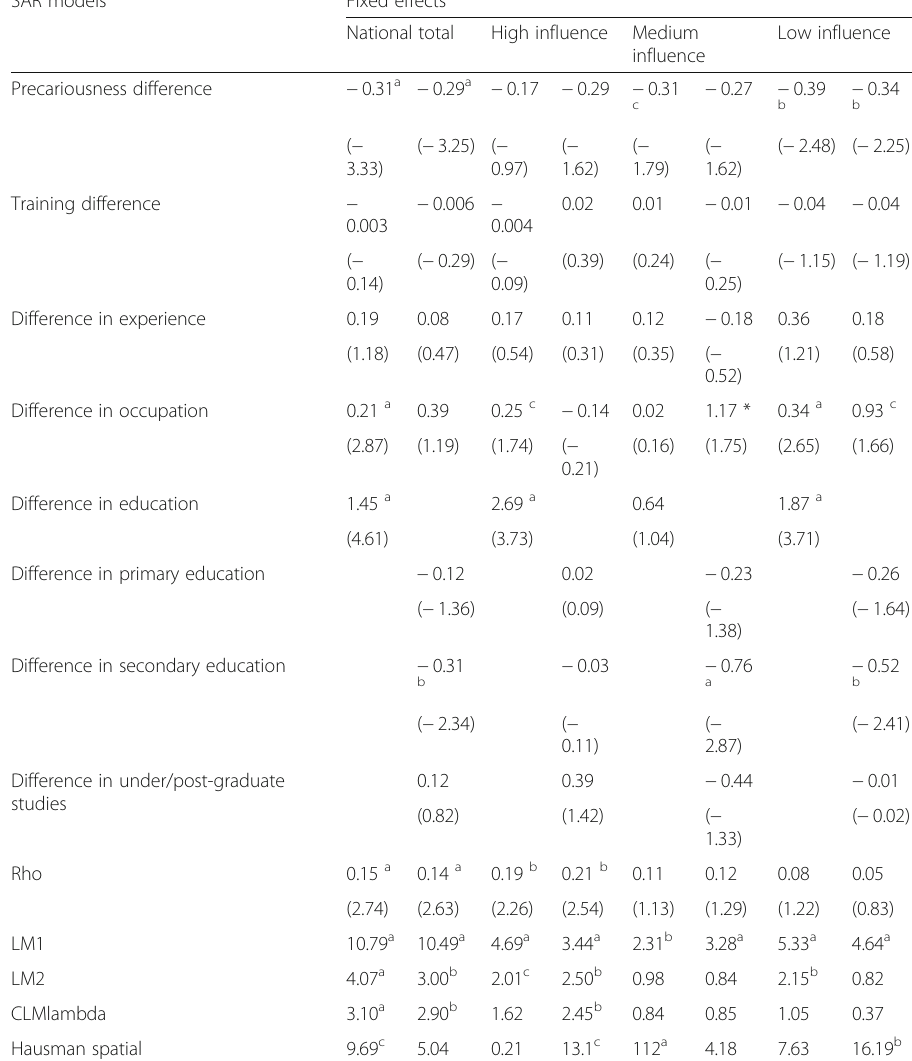
Table 1 Spatial panel data estimation by region. Fixed effects, 2005 – 2018 SAR